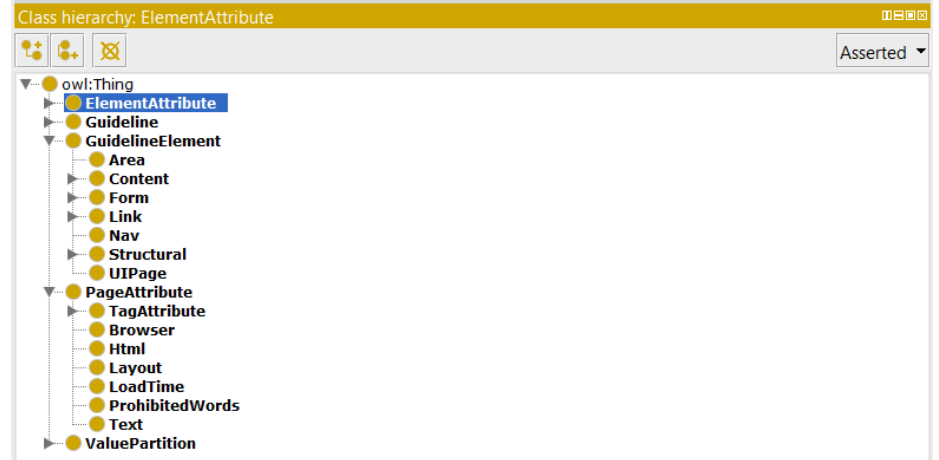
Figure 2. Class Hierarchy of defined usability ontology and some descendant classes: excerpt from